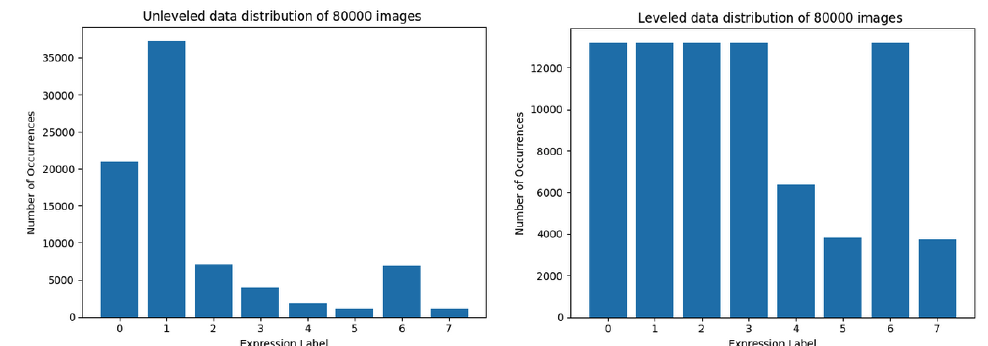
Figure 5. Data distribution of training set limited to 80,000 images. The left-hand side graph depicts the data distribution using the first method, while the second one—using the trimmed loading.